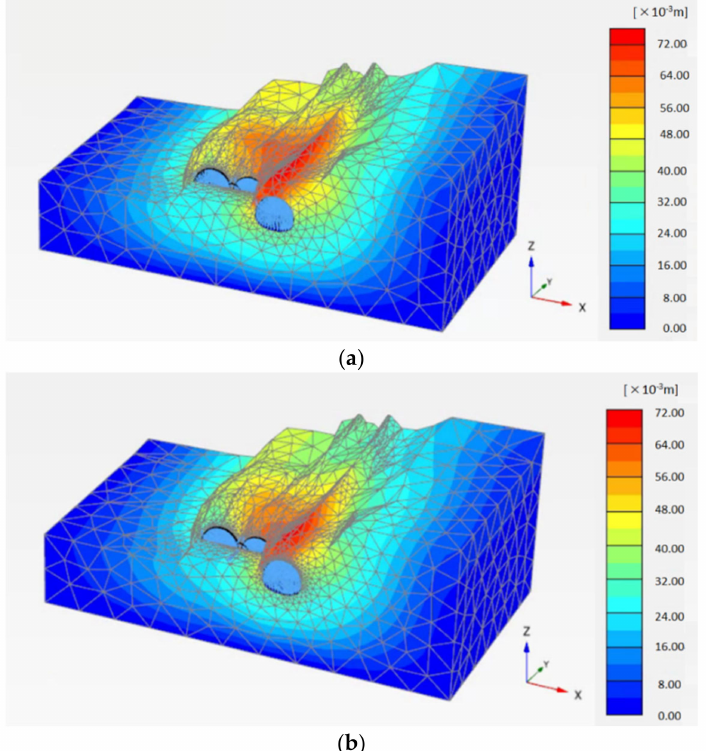
Figure 29. Shading distribution diagrams of the total displacement of the surrounding rock in the final excavation stage: ( a ) without pipe roofings and ( b ) with pipe